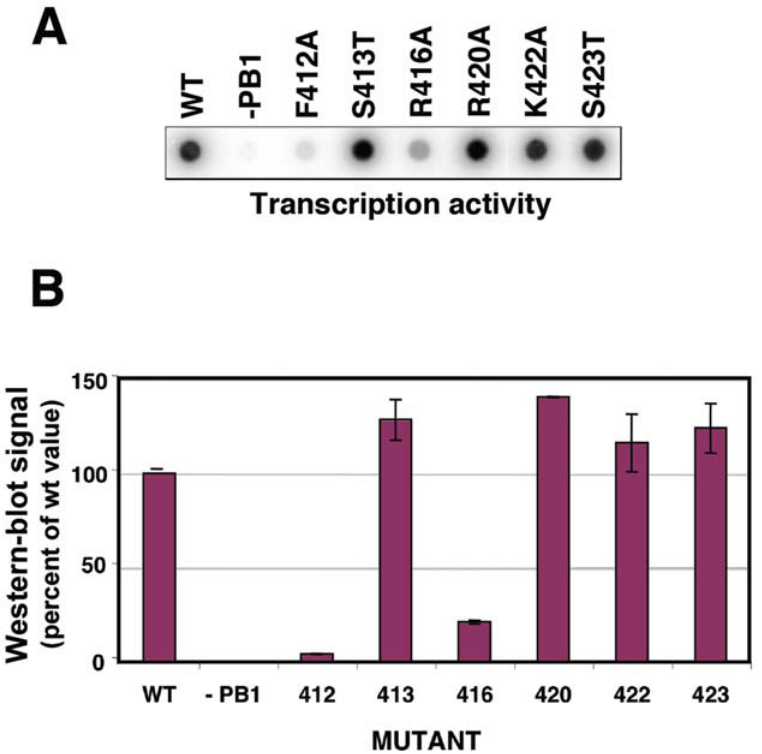
Figure 7. Replication in vivo of RNPs containing wt or mutant NP. The assay for in vivo replication was performed as described in Materials and Methods and the legend to Figure 6. The concentration of RNPs after purification by affinity chromatography was determined by in vitro transcription. (A) Results of a representative experiment, including the analysis of total cell extracts (Input) and the purified RNPs (RNPs). (B) Average and range of two experiments.